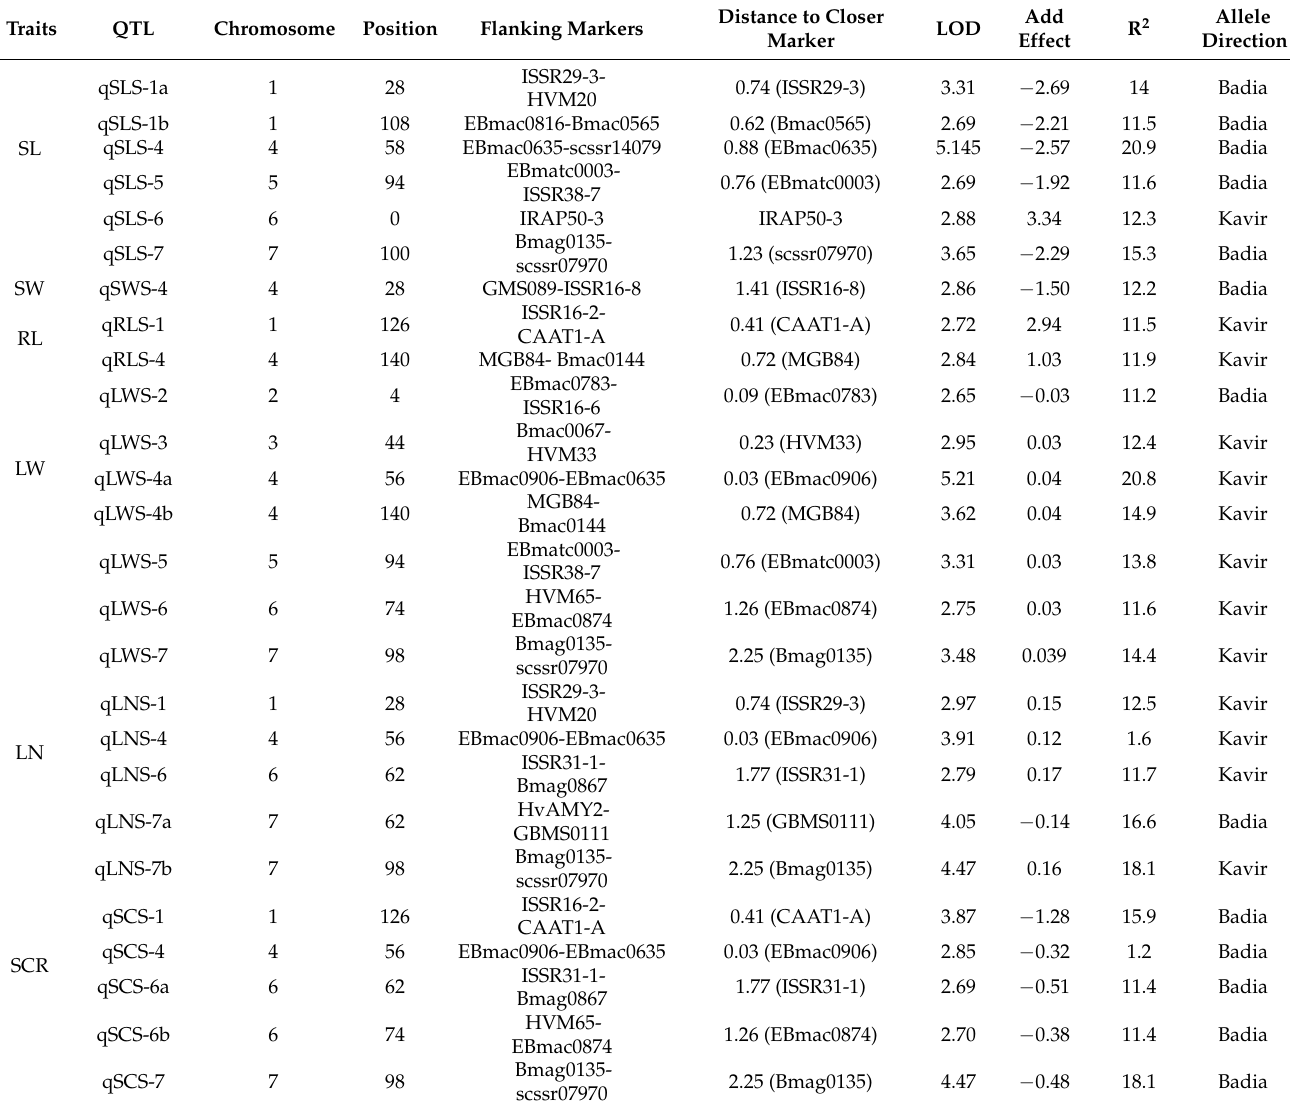
Table 10. QTLs controlling traits in barley under salinity stress at the seedling stage in the RIL population caused the Kavir and Badia